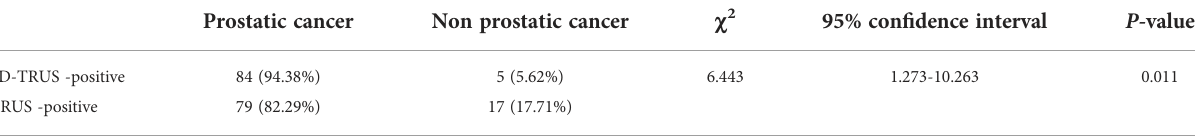
TABLE 6 Comparison of positive rate of biopsy session between 3D-TRUS and